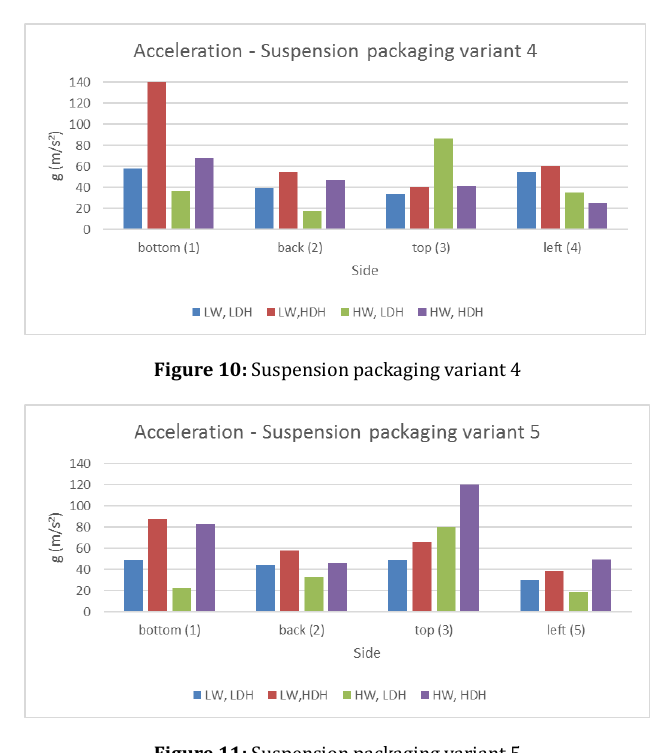
Figure 11: Suspension packaging variant 5